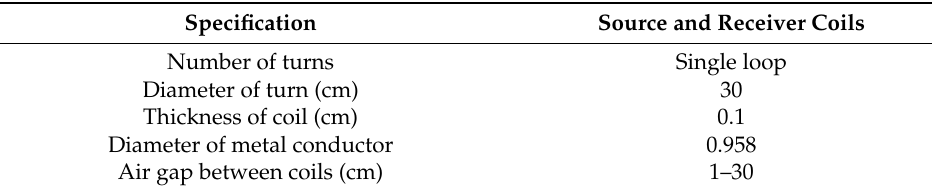
Figure 8. MTCWC during mobile charging. Table 2. Specification of transmitter and receiver coils.